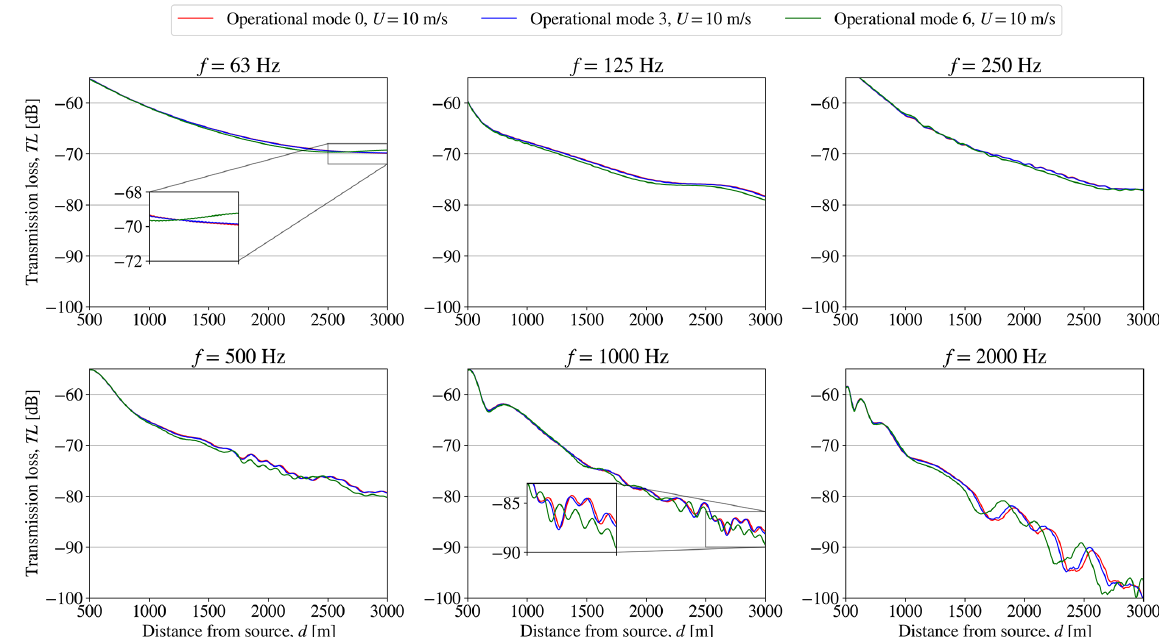
Figure 6. Setup 2: the transmission loss, TL, obtained from WindSTAR computations from a single SWT-DD-142 wind turbine positioned in the wake of a wind turbine subject to changing operational modes at each octave band frequency at a free field wind speed of U hub = 10ms − 1 at hub height.